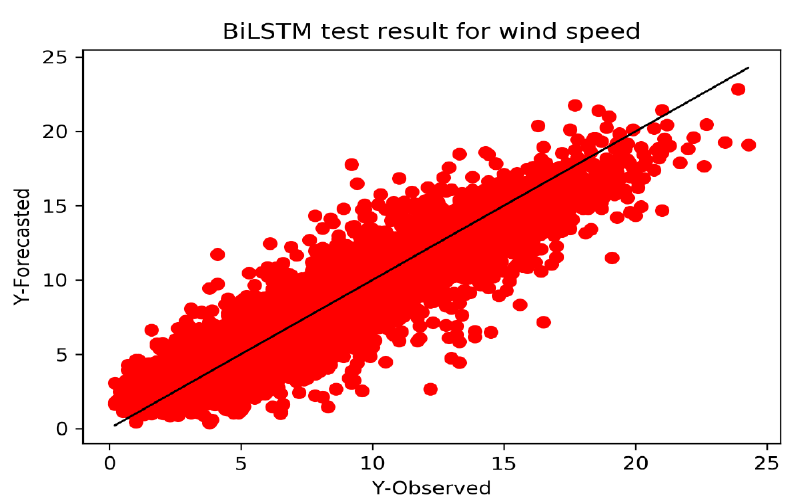
Figure 16. BiLSTM-based wind speed model error analysis.